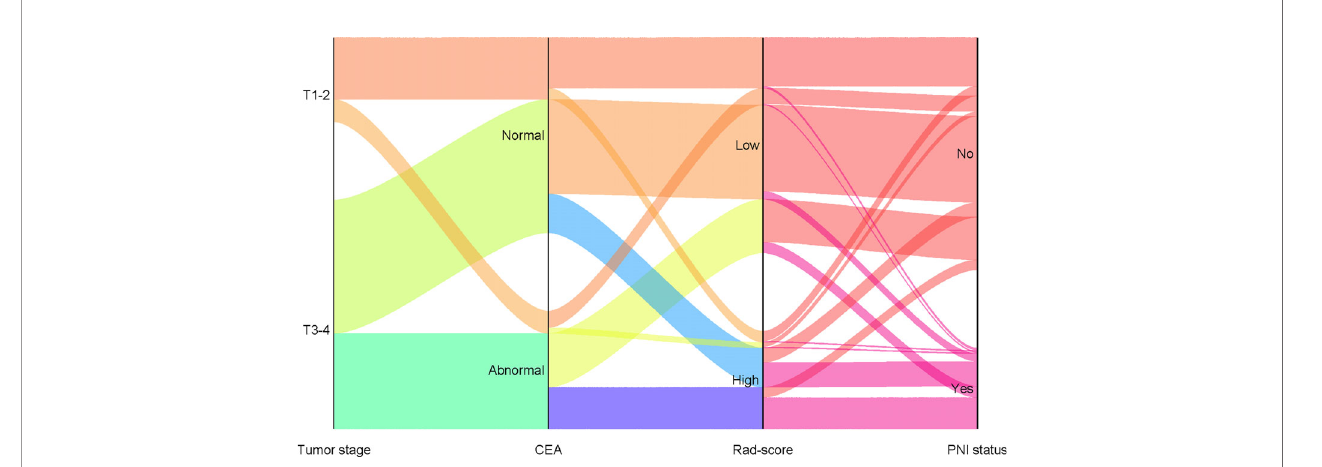
FIGURE 6 | Sankey diagram showing the relationship among tumor stage, CEA, rad-score, and pathological PNI status. (PNI, perineural invasion; CEA, carcinoembryonic